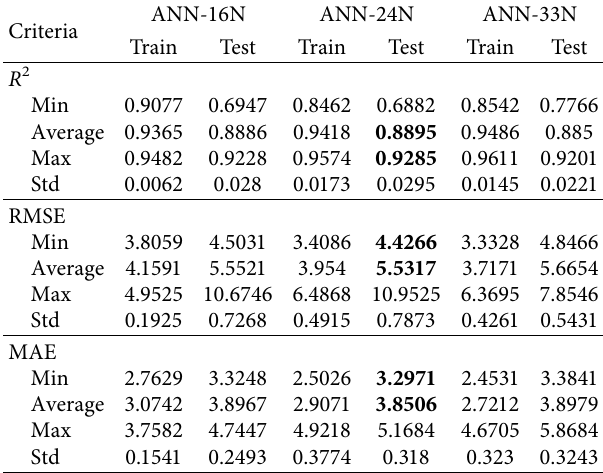
Table 4: Summary of different quality assessment criteria over 100 simulations with different ANN